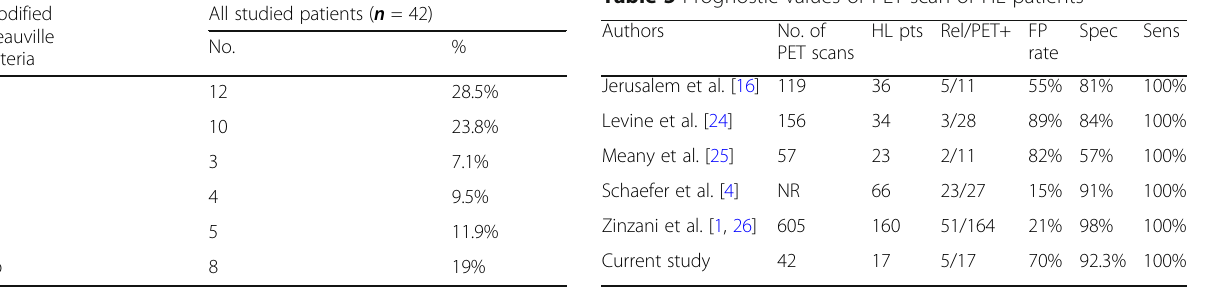
Table 4 Modified Deauville criteria of all studied patients Modified Deauville criteria